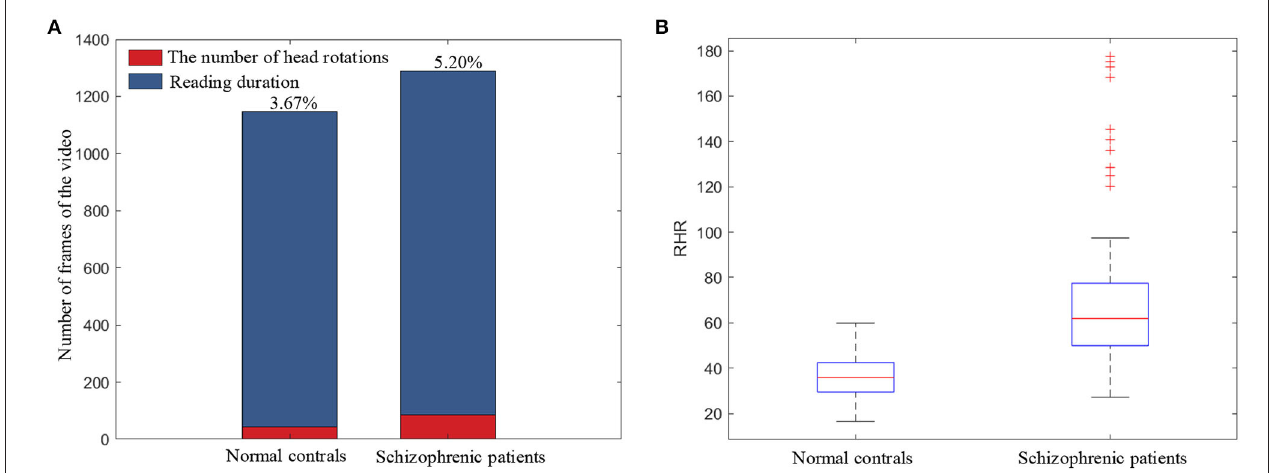
FIGURE 8 | (A) The ratio of head rotations to the reading duration. (B) Boxplot of RHR.